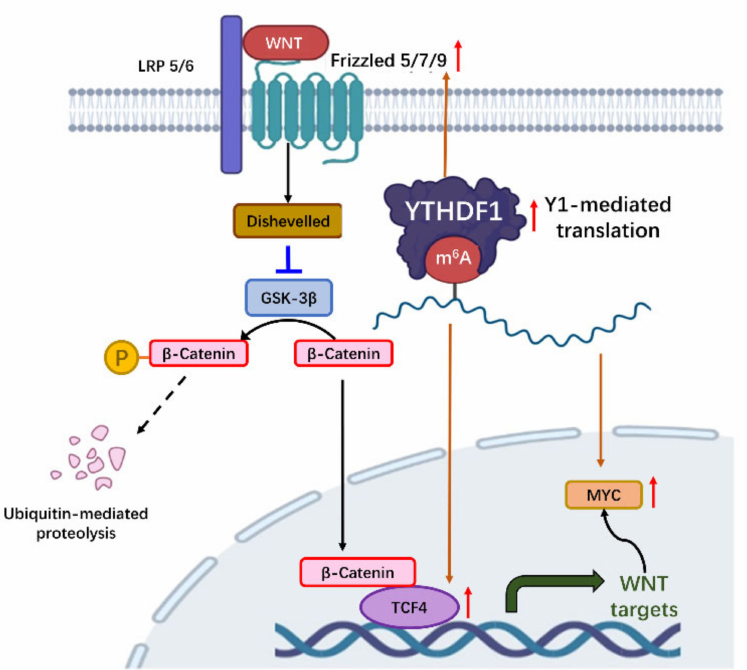
Figure 2. The function of YTHDF1 in promoting WNT/ β -catenin signaling in gastrointestinal cancers. YHTDF1-driven translation of m 6 A-modified gene targets includes Frizzled 5/7/9, TCF4, and c-Myc. Increased Frizzled genes promoted the stability of β -catenin by inhibition of GSK3 β , and elevated TCF4 enhanced β -catenin-mediated transcription. c-Myc, a key oncogenic target of WNT/ β -catenin signaling, is also induced by YTHDF1. Part of the figure is created with BioRender.com. YTHDF1 also exerts a pro-tumorigenic effect by altering the tumor microenviron- ment. Inflammation is an etiological factor in the initiation and progression of